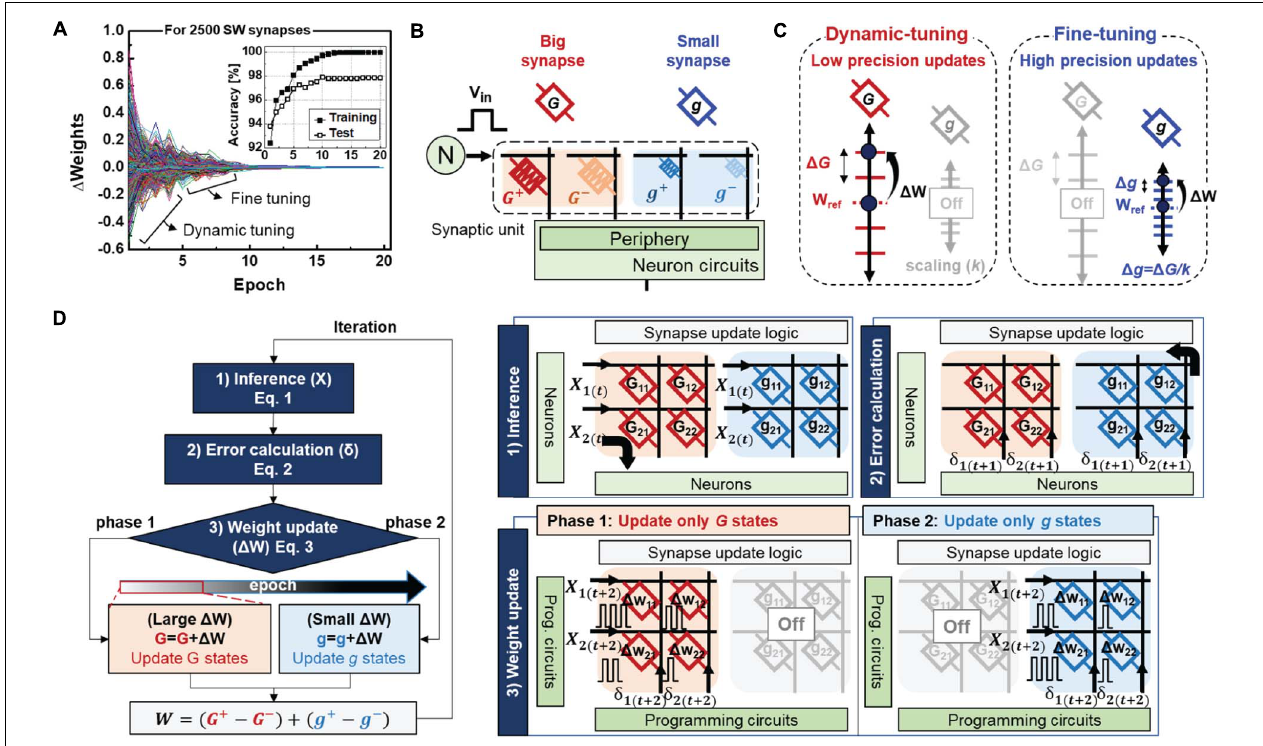
FIGURE 2 | (A) Weight changes of ideal synapses as a function of epoch during software training. The inset shows training and test accuracy (B) A hybrid synapse is implemented with four different RRAMs. Each RRAM (C) Weight states of the big and small synapse for the dynamic-tuning and fine-tuning phases. (D) Flow chart and corresponding working principles of the proposed neural network. Here, the subscript (t) indicates the time index of the sequence of actions.